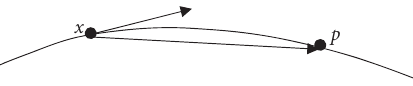
Figure 3: Tangent vector: the vector from X to P